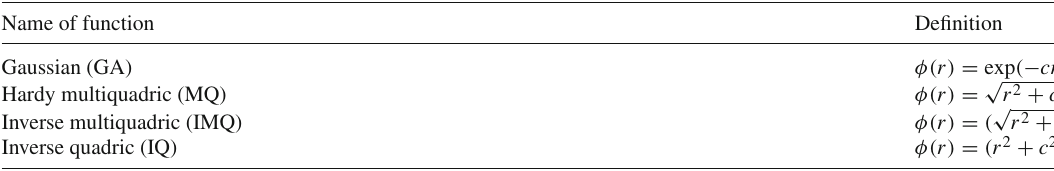
Table 1 Some well-known functions that generate